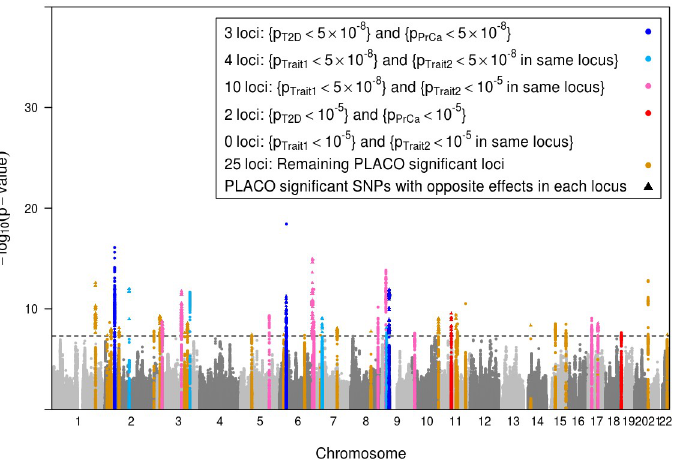
Fig 4. Manhattan plot of the PLACO p-values of pleiotropic association of common genetic variants with outcomes (traits) T2D and PrCa. The black horizontal dashed line corresponds to genome-wide significance level α = 5 × 10 − 8 . The 44 loci with genome-wide significant pleiotropic lead SNP have been highlighted. A locus is defined by clumping SNPs in ± 500 Kb radius around the lead SNP and with LD r 2 > 0.2. Within each locus, if a PLACO significant SNP has genetic effects in opposite directions for T2D and PrCa, it is plotted as a solid triangle (24 such loci), else as a solid circle. Each identified pleiotropic locus is categorized (color-coded) as follows. Three loci harbor SNPs that are marginally genome-wide significant for both T2D and PrCa (single-trait p < 5 × 10 − 8 ). Four loci contain SNPs that are marginally genome-wide significant for one disease, and in close proximity (i.e., in the same locus) with another SNP marginally genome-wide significant for the other disease. There are 10 loci where SNPs are marginally genome-wide significant for one disease and in close proximity with another SNP marginally suggestively significant (single-trait p < 10 − 5 ) for the other disease. Two loci harbor SNPs that are marginally suggestively significant (but not genome-wide significant) for both T2D and PrCa. There is no locus that contains SNPs that are marginally suggestively significant (but not genome-wide significant) for one disease, and in close proximity with another SNP marginally suggestively significant (but not genome-wide significant) for the other disease. The rest of the 25 loci identified by PLACO contain SNPs that are not even marginally suggestively significant for either T2D or